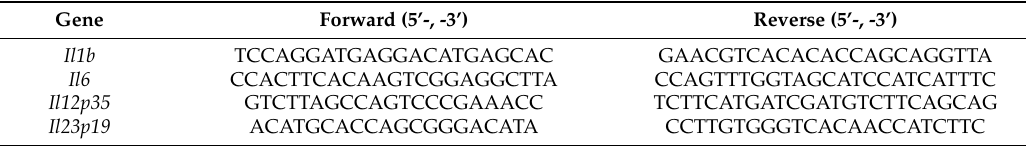
Table 1. Quantitative real-time PCR primers sequence.